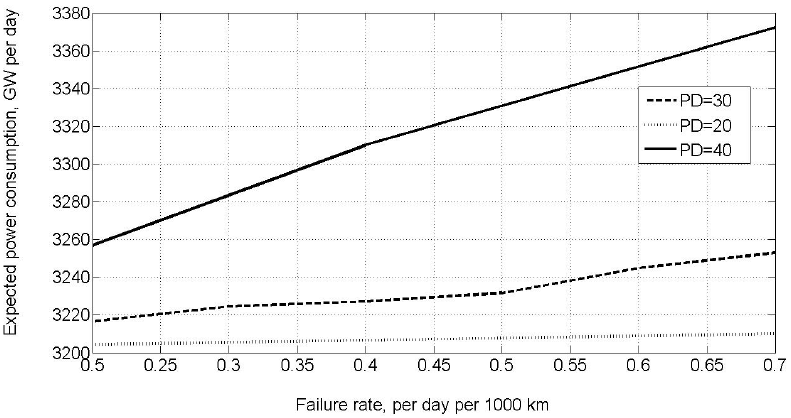
Figure 10. Power consumption dependence on cracking rate and detection effectiveness.